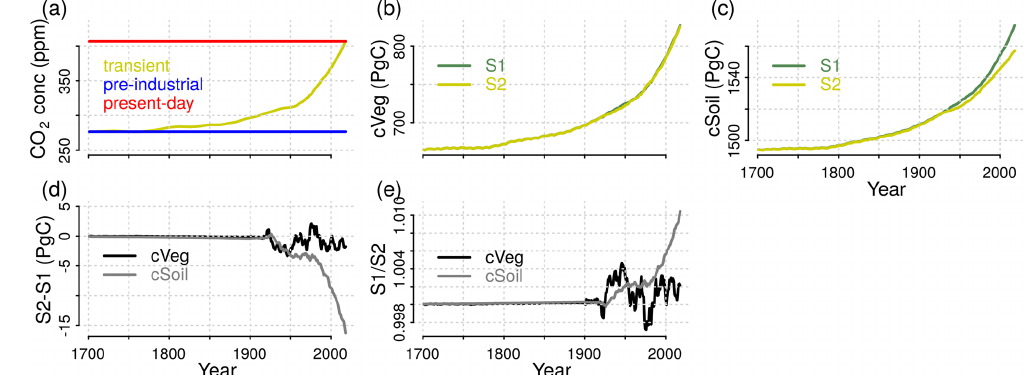
Figure A1. Global forcings of annual CO 2 fields and ensemble mean C stocks in vegetation and soil of the S1 (pre-industrial climate and transient CO 2 ) and S2 (transient climate and CO 2 ) simulation runs. Additionally, the differences and ratios in S1 and S2 C stocks in vegetation and soil are plotted.